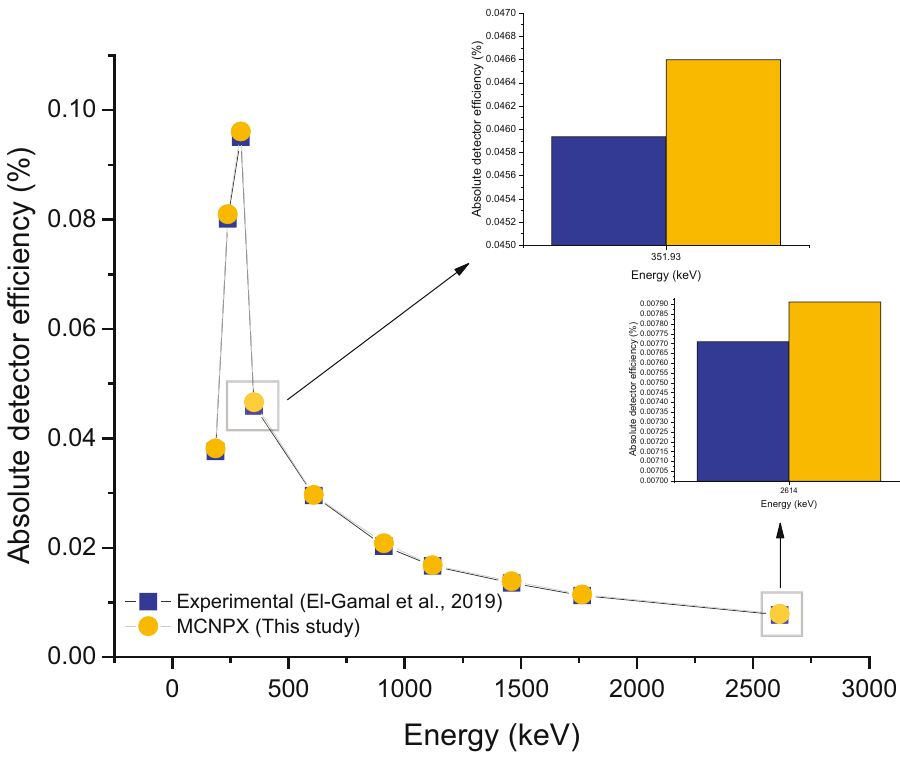
Figure 3: Comparison of absolute detector e ffi ciency ( ε ) values obtained from experimental [ 26 ] and MCNPX simulation